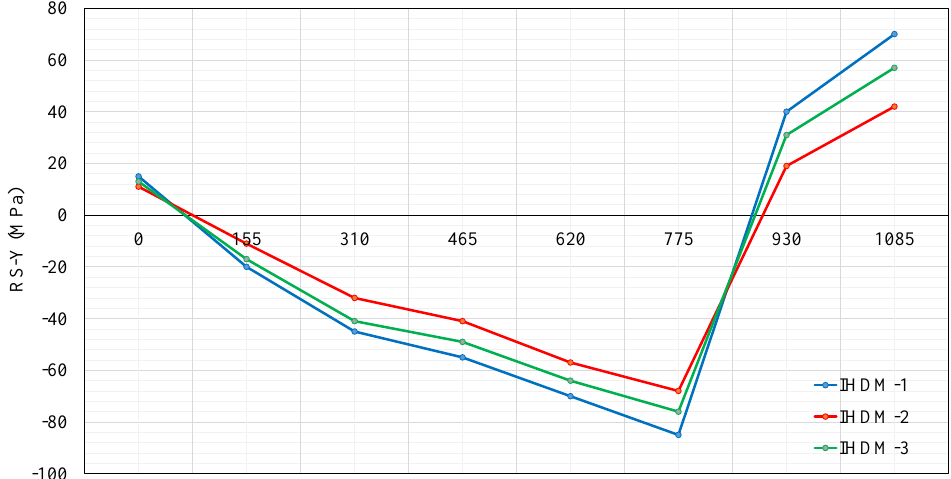
Figure 13. CFRP residual stresses in the Y-direction.